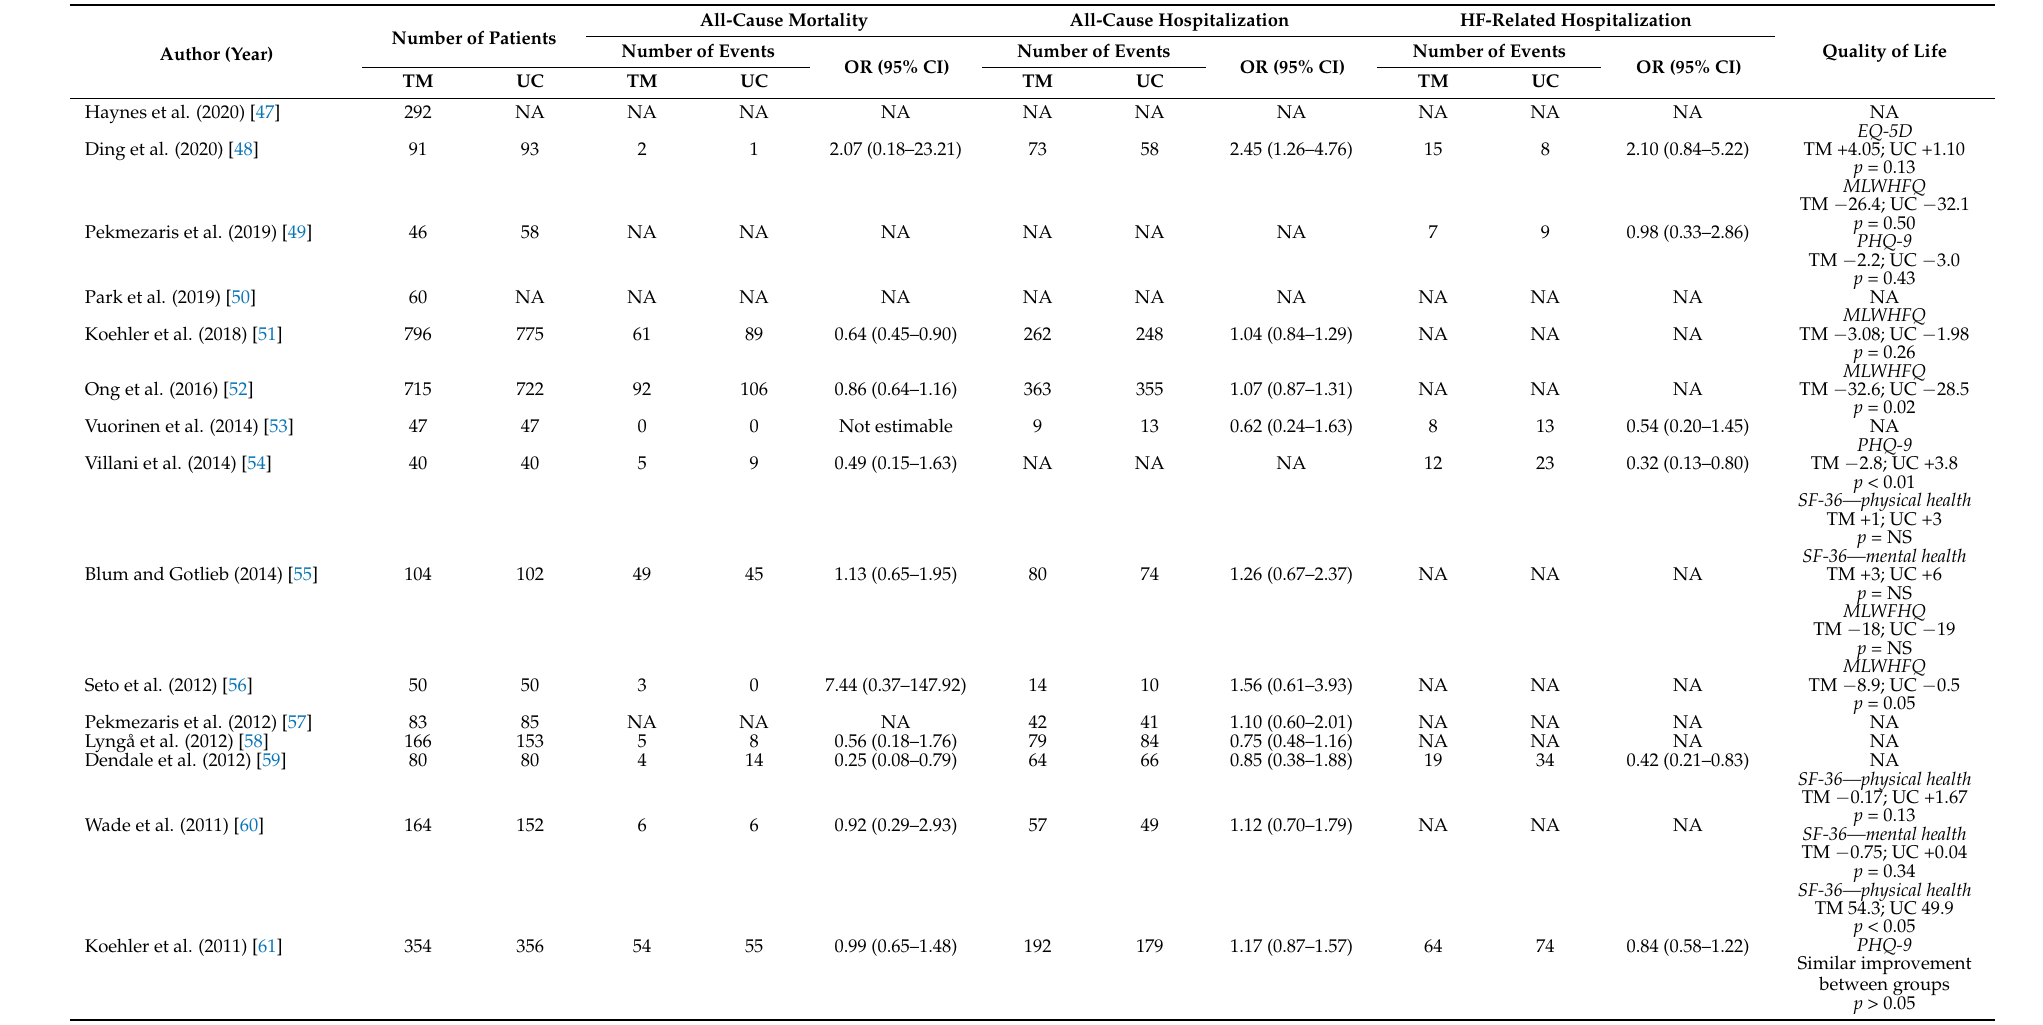
Table 4. Clinical outcomes of non-invasive telemonitoring